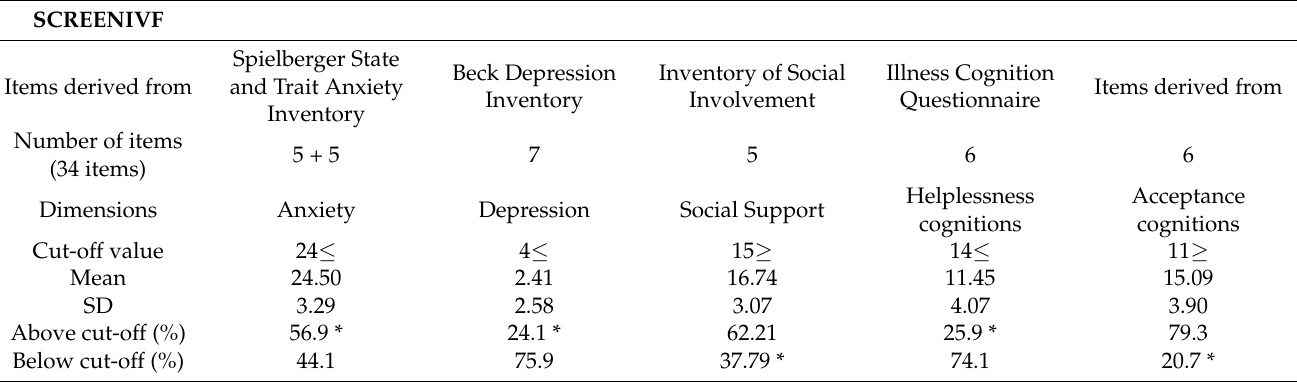
Table 2. Assessment of psychological maladjustment based on the Hungarian version of SCREENIVF ( n =